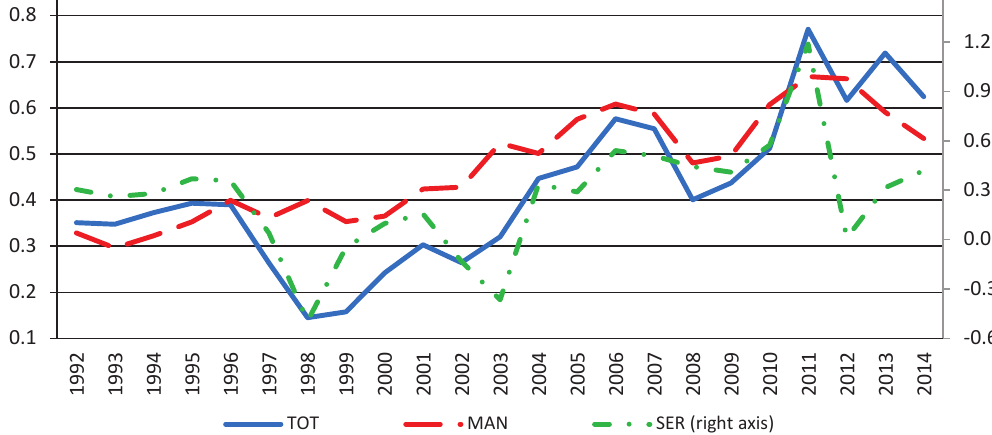
Figure 4 Contribution of the OP term to aggregate wage changes ∆ ∆ ( OP / ) w tm tm , by sector.